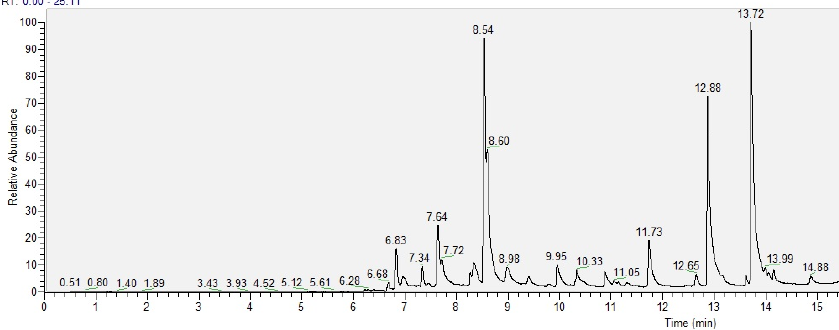
Figure 1. GC chromatogram of the volatiles in lemon IntegroPectin.